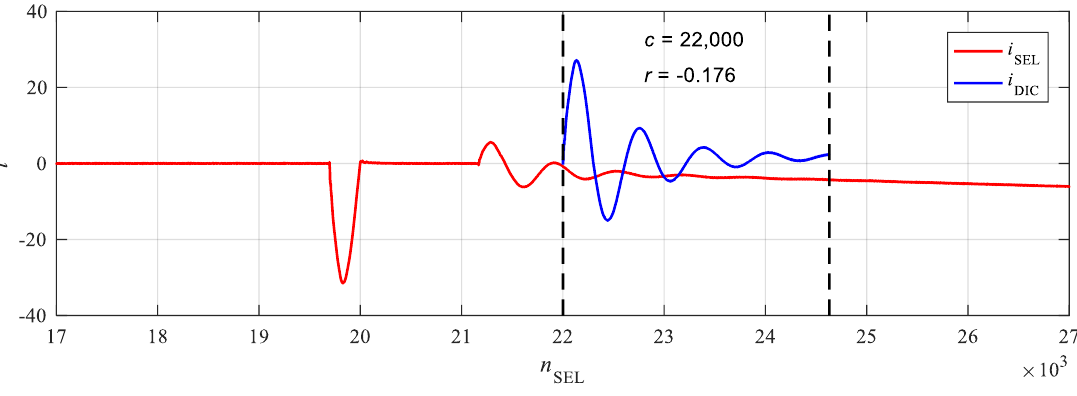
Figure 11. Determining the correlation for sample measurement data, delay c = 22,000.